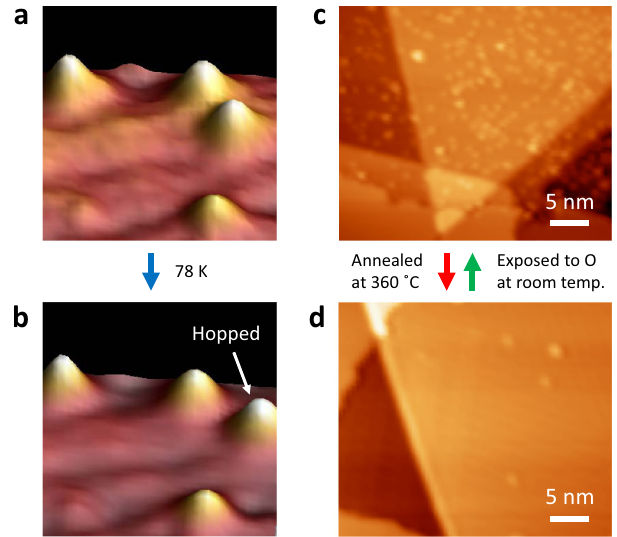
Fig. 5 Thermal stability of oxidized borophene. STM images a before and b after hopping of an oxygen adatom on borophene at low temperature (78 K). STM images of O-oxidized borophene c before and d after annealing at 360 °C, which were acquired from different surface